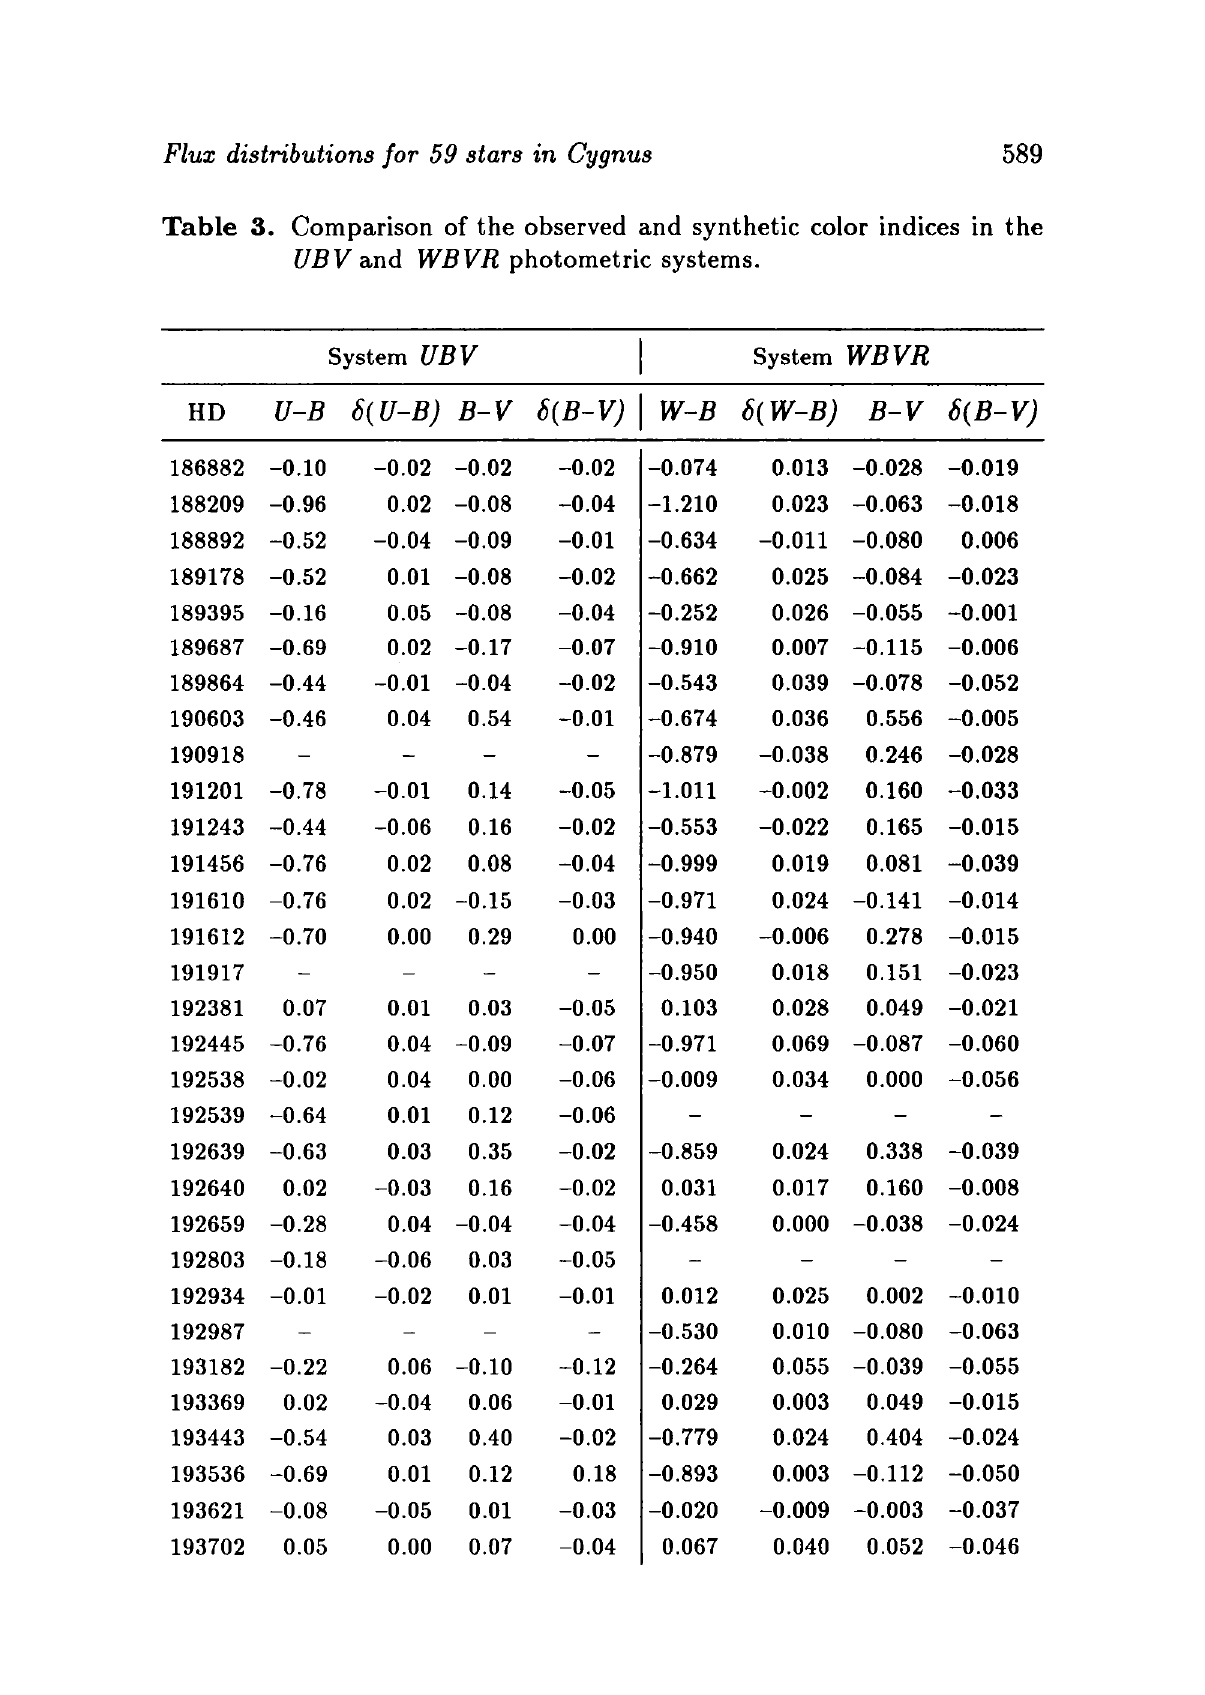
Table 3. Comparison of the observed and synthetic color indices in the UBV and WBVR photometric